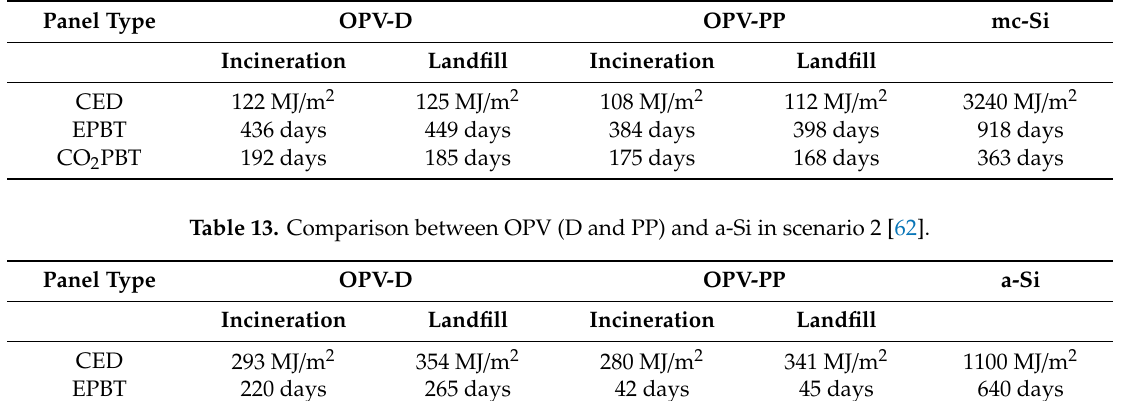
Table 12. Comparison between OPV (D and PP) and mc-Si in scenario 1 [62]. Panel Type